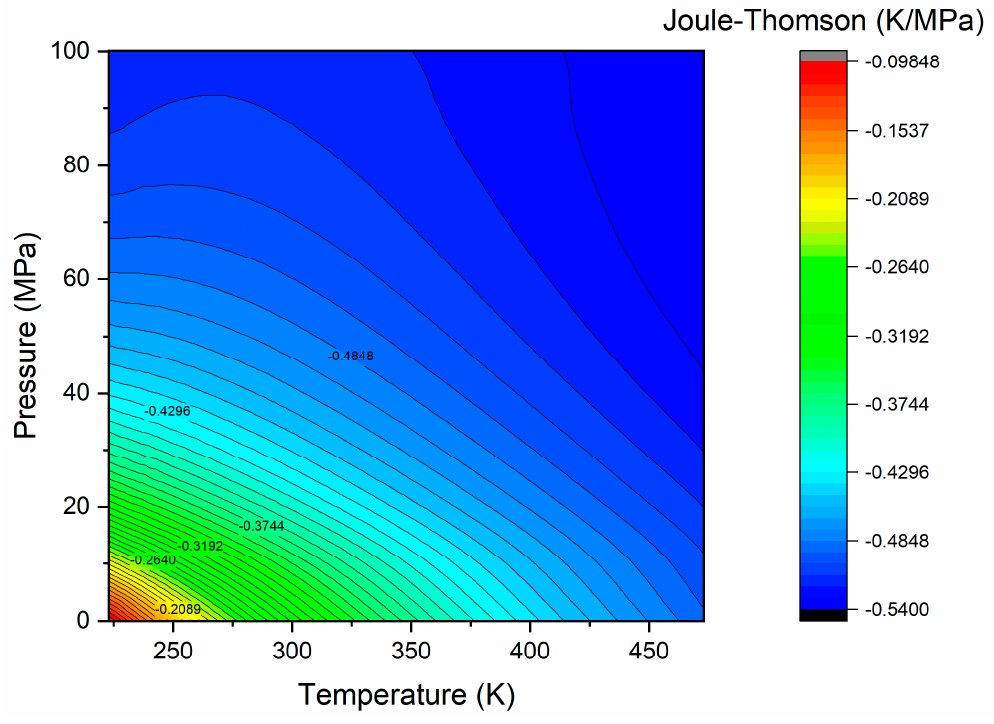
Figure 10. Joule-Thomson coefficient values for several pressure and temperature levels. Data processed from